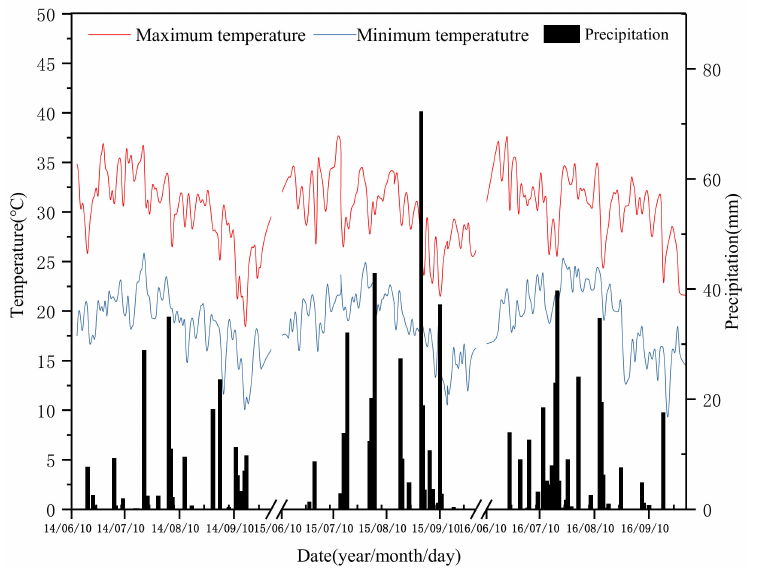
Figure 1. Daily maximum temperature, minimum temperature, and precipitation during maize growing seasons in